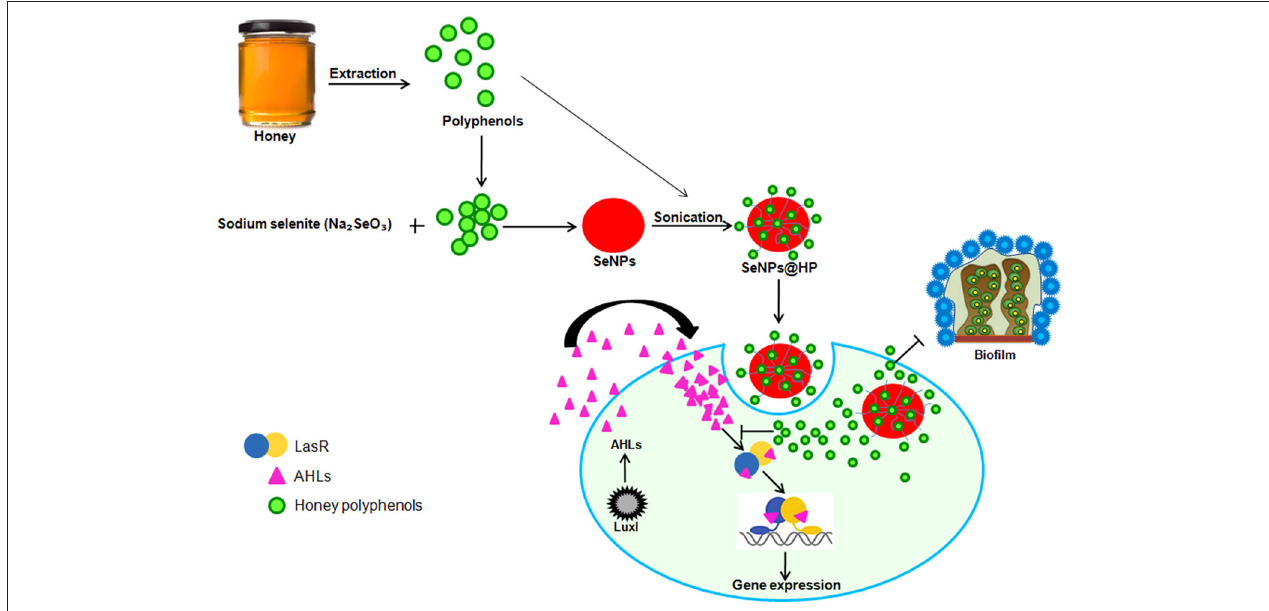
FIGURE 9 | Pictorial representation for the biofabrication of scaffold of SeNPs and HP (SeNPs@HP) and its anti-QS activity in P. aeruginosa PAO1.